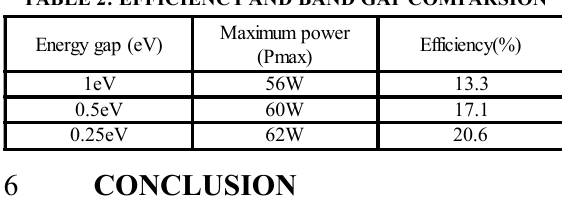
TABLE 2: EFFICIENCY AND BAND GAP